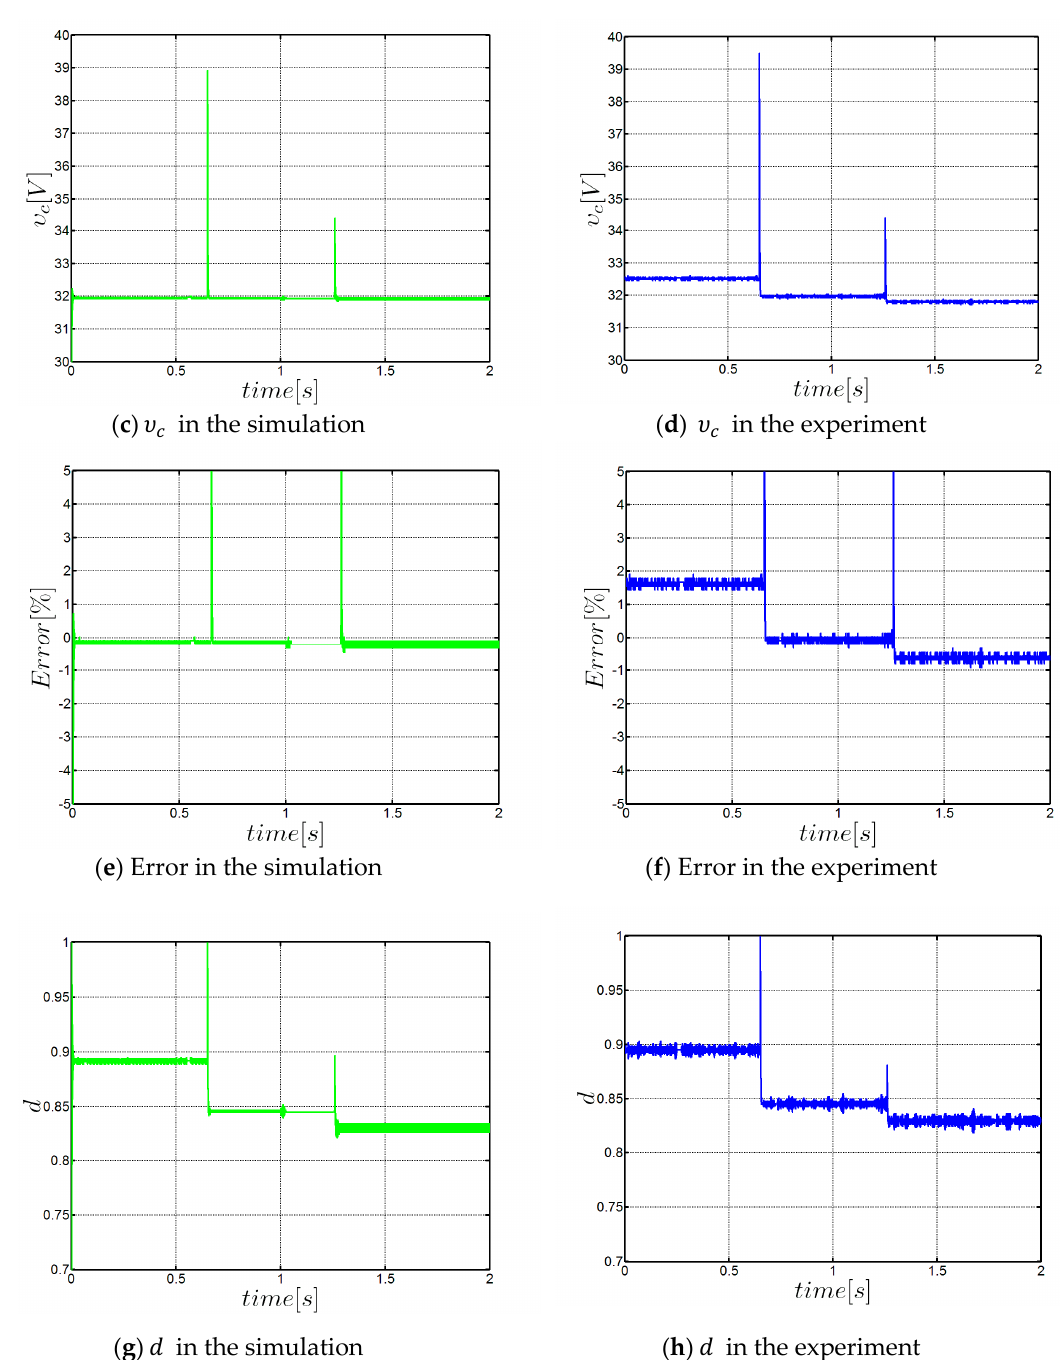
Figure 15. Behavior of the load estimator R when the values change according to Table 4 for the buck converter controlled by ZAD-FPIC without load estimator, one delay period, K s = 5, N = 1, and γ = 1 . Table 7. Error in the controlled signal.